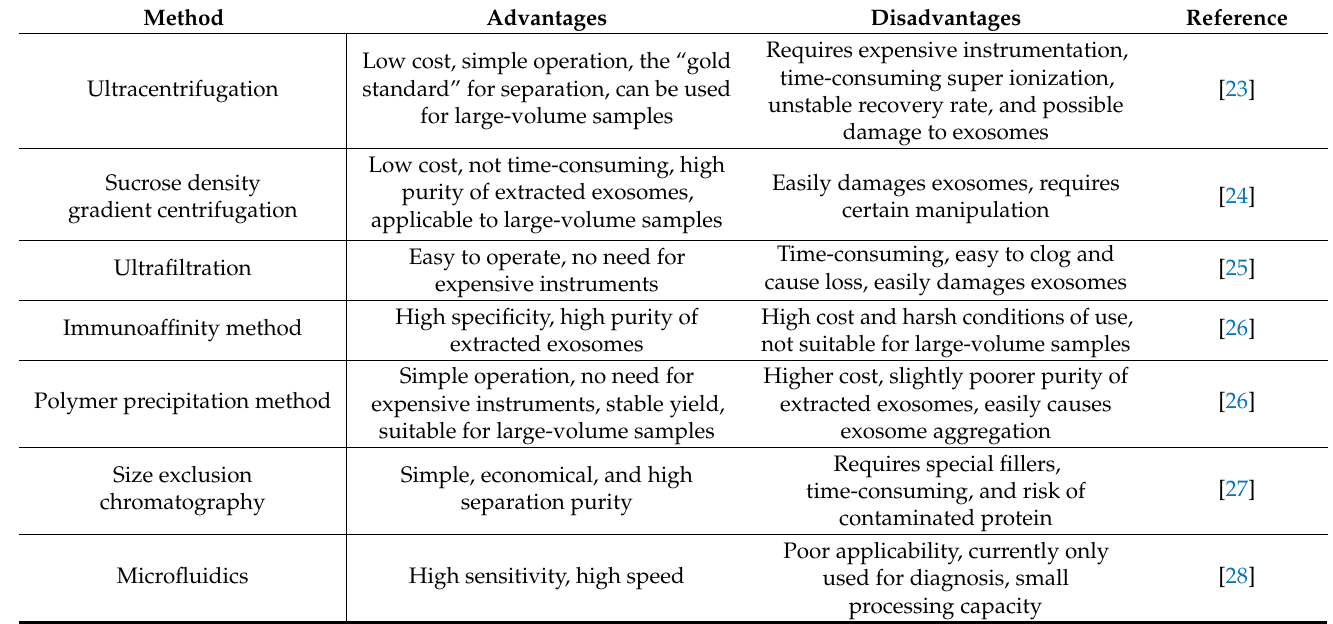
Table 1. Comparison of the advantages and disadvantages of common exosome extraction